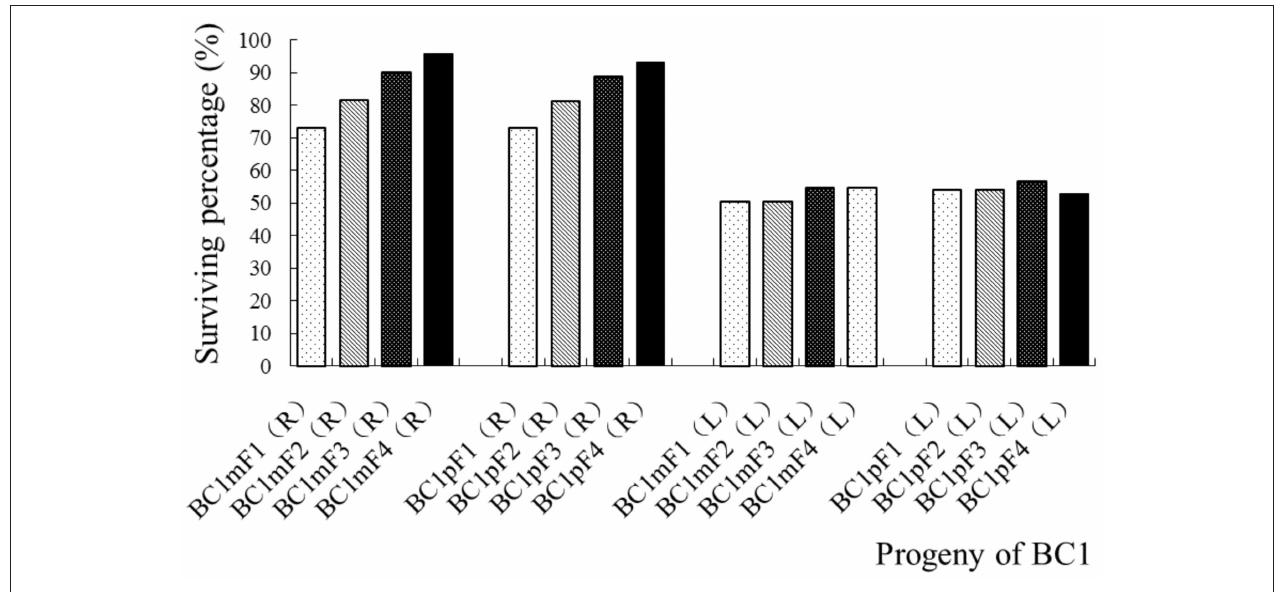
FIGURE 3 | Surviving percentage of the first- to fourth-generation progenies of BC1 after spraying with glyphosate or glufosinate. BC1mF1(R) to BC1mF4(R) and BC1pF1(R) to BC1pF4(R) are the first- to fourth-generation progenies of the first backcross generation (BC1) obtained from wild Brassica juncea × F1R or F1R × wild B. juncea , respectively. BC1mF1(L) to BC1mF4(L) and BC1pF1(L) to BC1pF4(L) are the first- to fourth-generation progenies of the first backcross generation (BC1) obtained from wild Brassica juncea × F1L or F1L × wild B. juncea , respectively. F1R and F1L indicate glyphosate- or glufosinate-tolerant F1 hybrids from wild B.